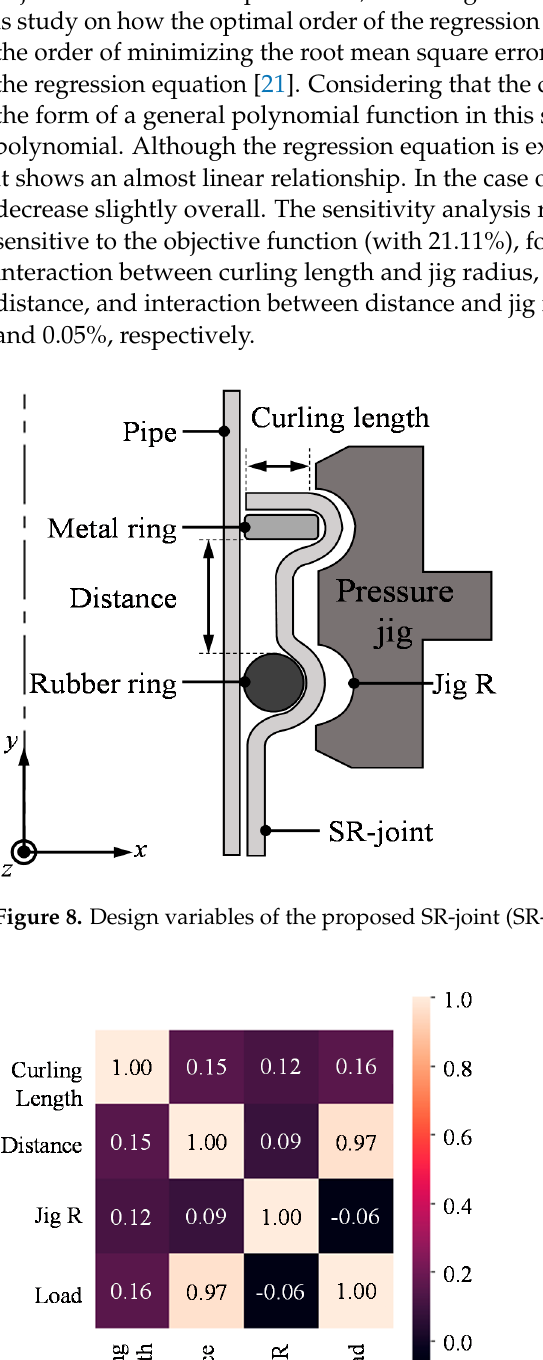
198.50 Figure 10. Result of sensitivity analysis.